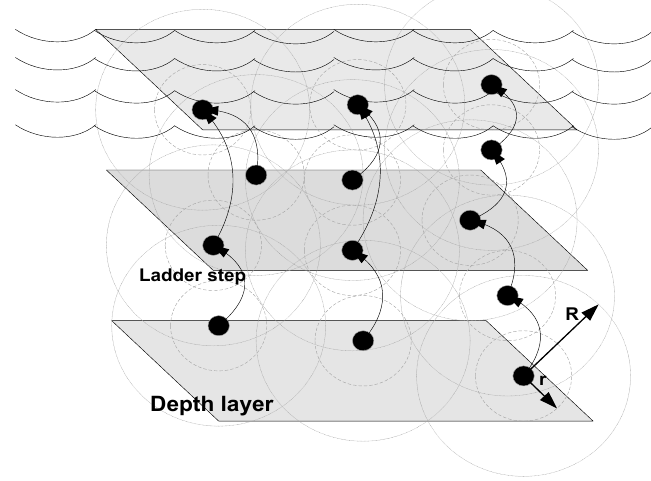
Figure 2. Ladder step analogy of